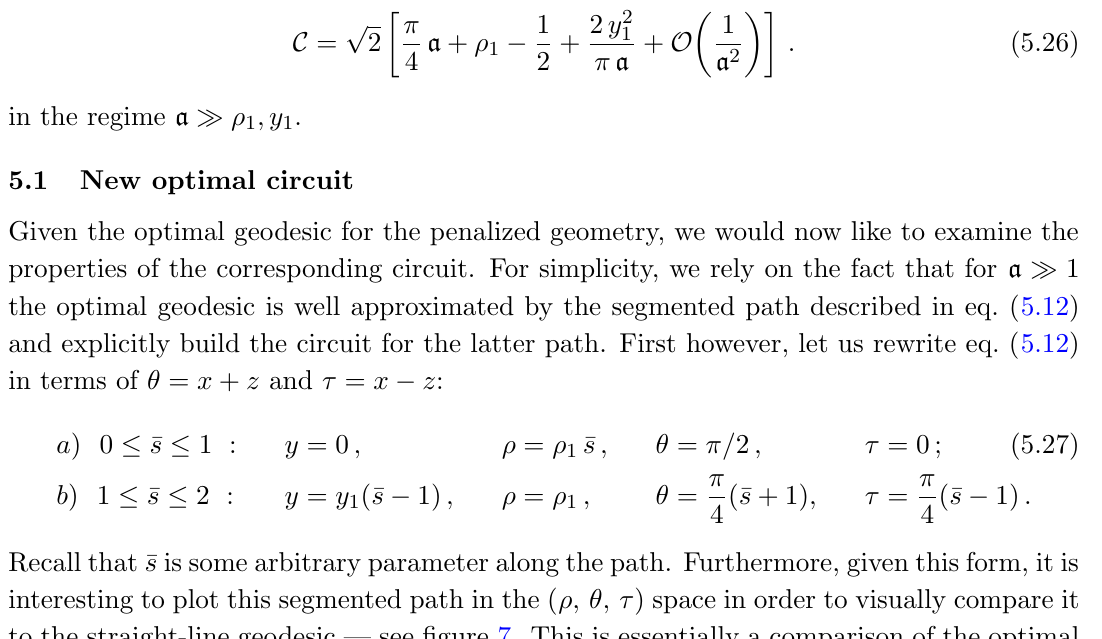
( a ) in eq. (5.21), for (cid:15) = 10 (cid:0) 15 trans